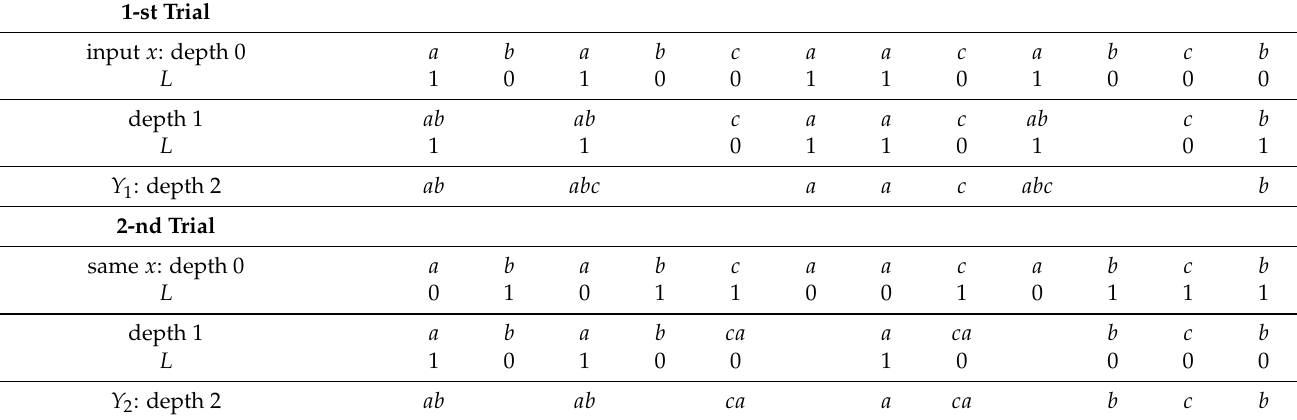
Table 1. Example of multiple subword segmentation using LCP-dropout for the single sentence ‘ x = ababcaacabcb ’ with the hyperparameters ( v , (cid:96) , k ) = ( 6,5,0.5 ) , where the meta symbol − is omitted, and L is the label of each vocabulary assigned by LCP. The resulting subword segmentation is Y = { Y 1 , Y 2 } .